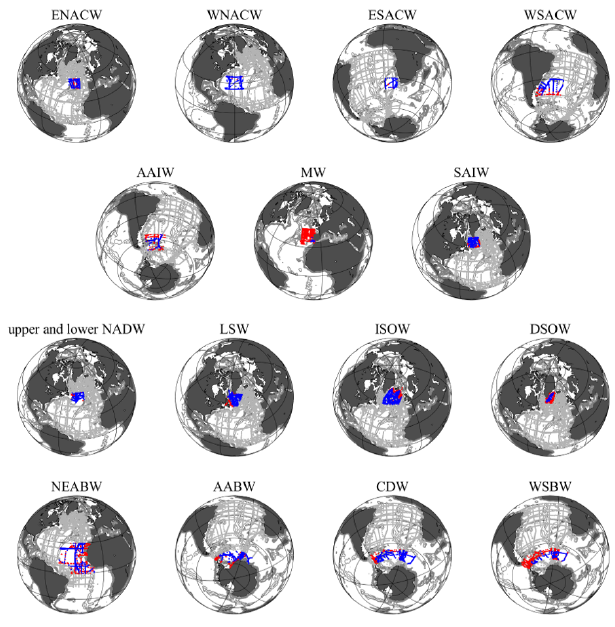
Figure 5. Formation/redefining areas of the 16 main water masses in the Atlantic Ocean. The red dots show stations in formation area, the blue dots show stations where the SWT was found, and the grey dots show all the stations from the GLODAPv2 dataset.